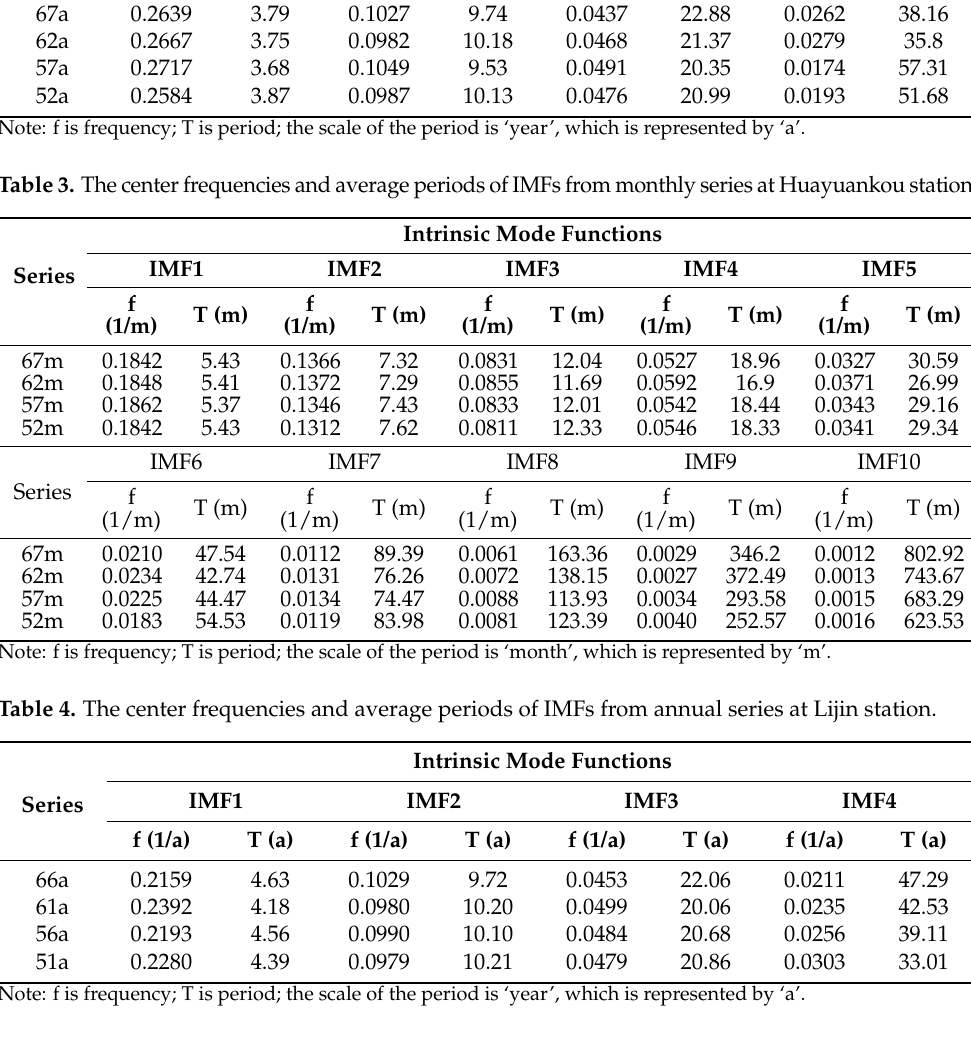
Table 5. The center frequencies and average periods of IMFs from monthly series at Lijin